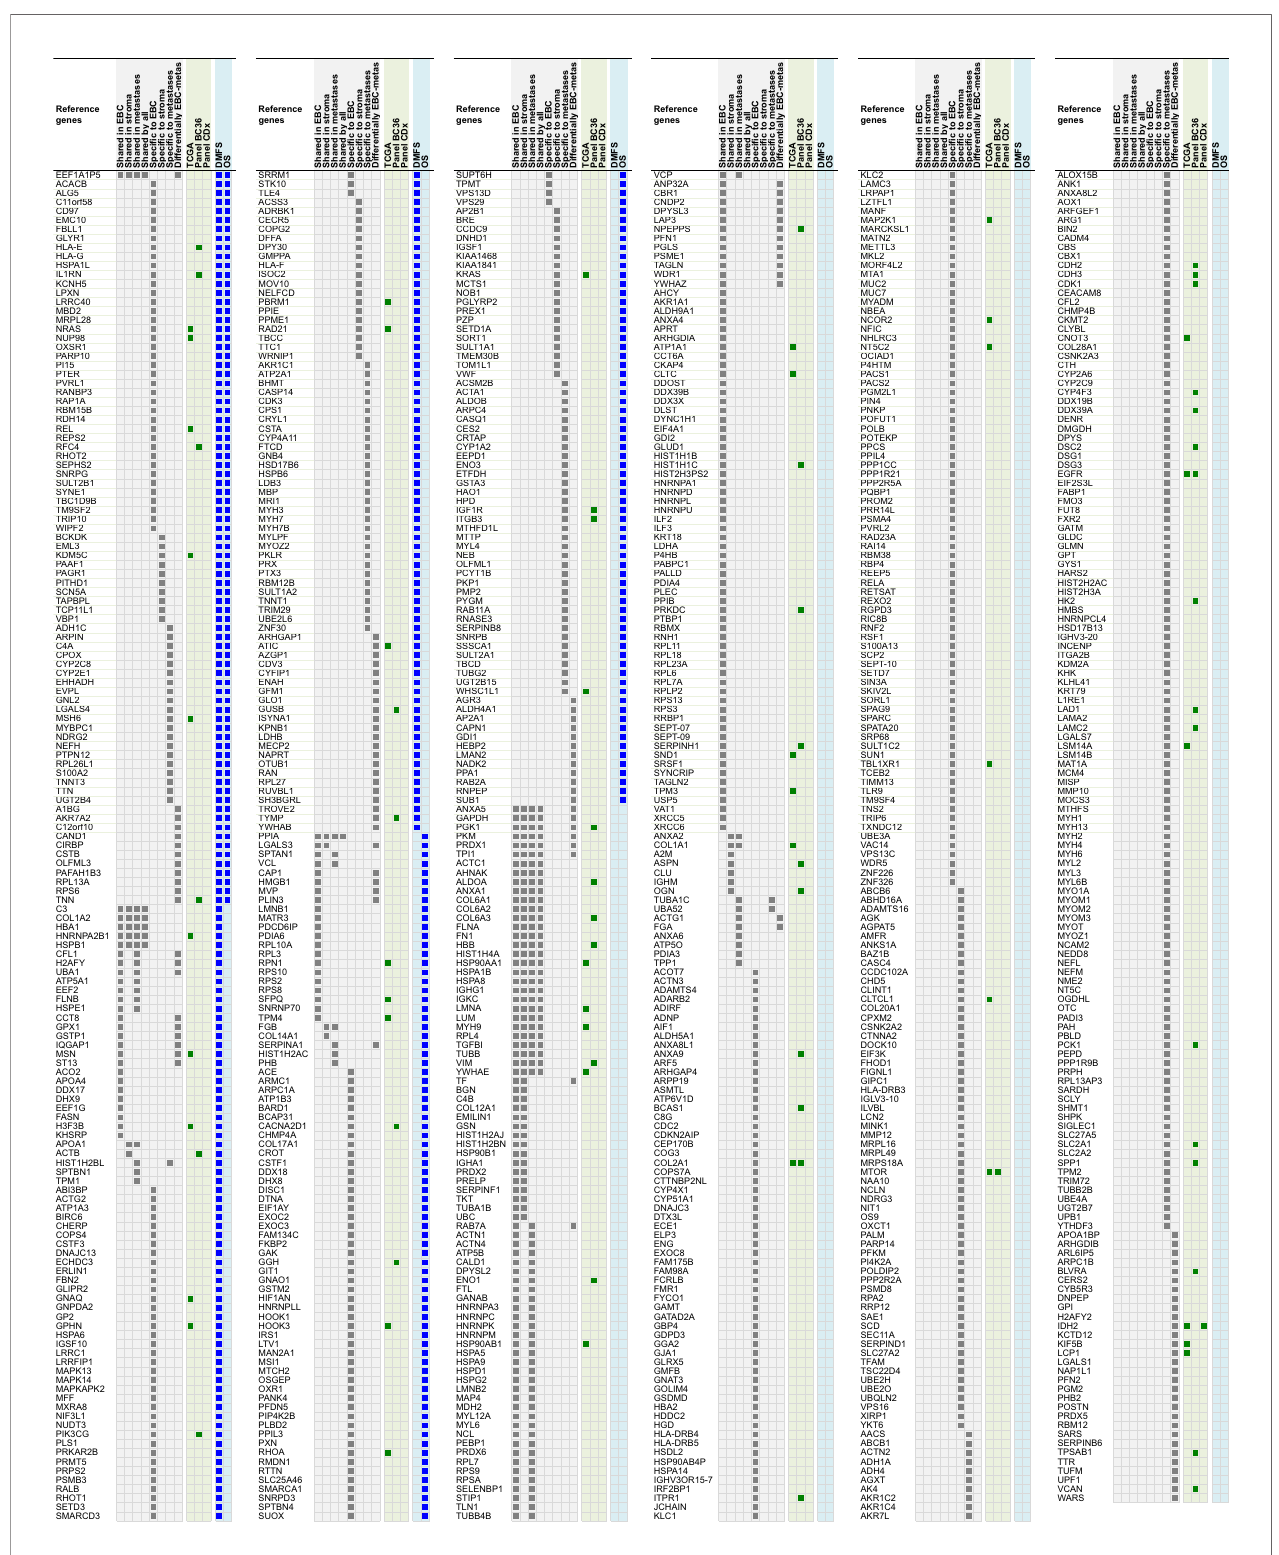
FIGURE 7 | Proteins shared, speci fi c or differentially expressed in the clonal proteome dataset (in grey). 892 proteins are indicated with their reference gene. Proteins also found in TCGA, BC360 or CDx datasets are indicated in green. Genes associated with DMFS or OS using publically available databases are shown in blue. EBC, early breast cancer; DMFS, distant metastases free survival; OS, overall